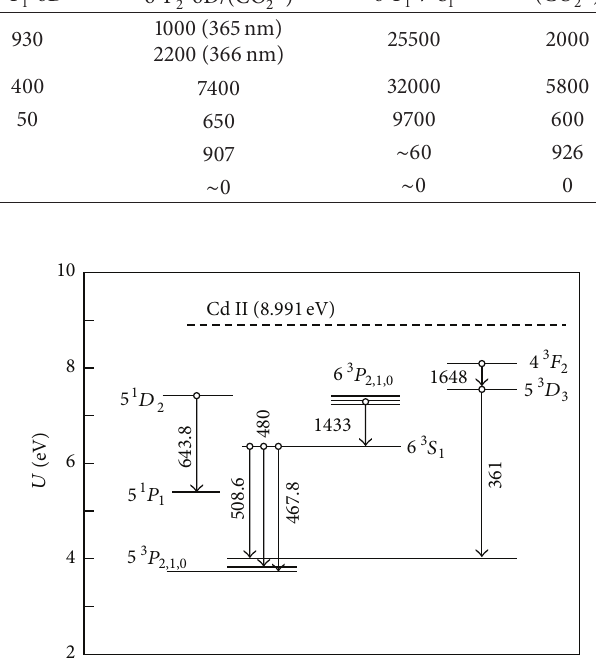
Figure 3: Scheme of some levels of cadmium